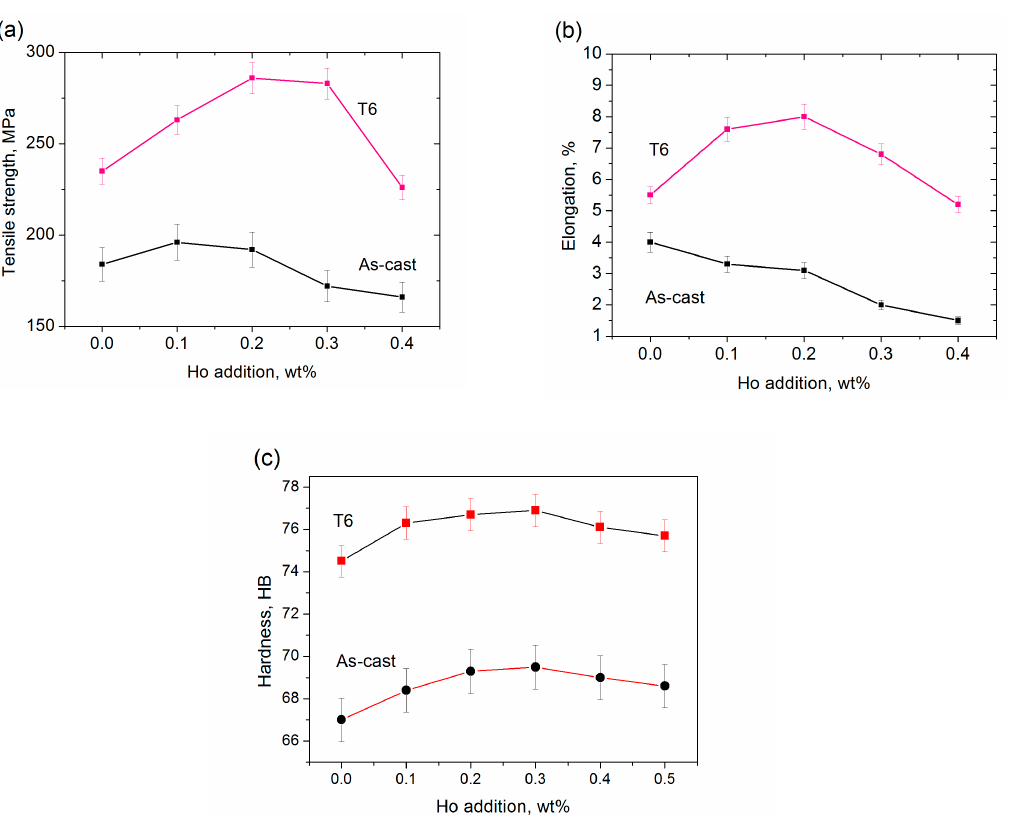
Figure 7. Mechanical properties of the Ho-modified A356 alloys, ( a ) tensile strength; ( b ) elongation; ( c ) hardness.